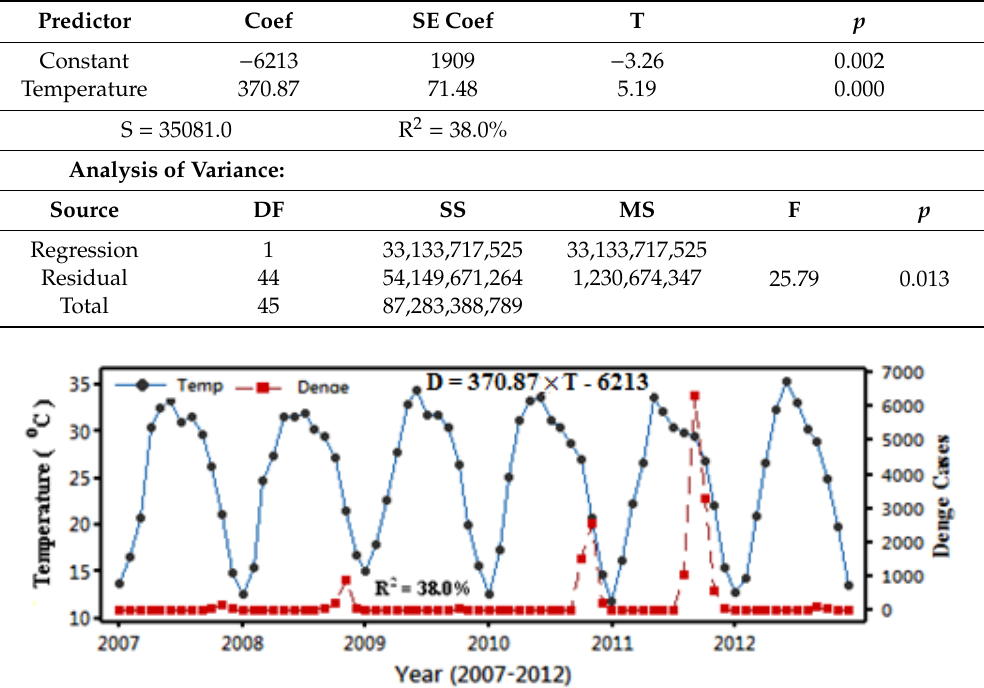
Figure 10. Comparison of monthly dengue versus monthly temperature with regression equation in Lahore,